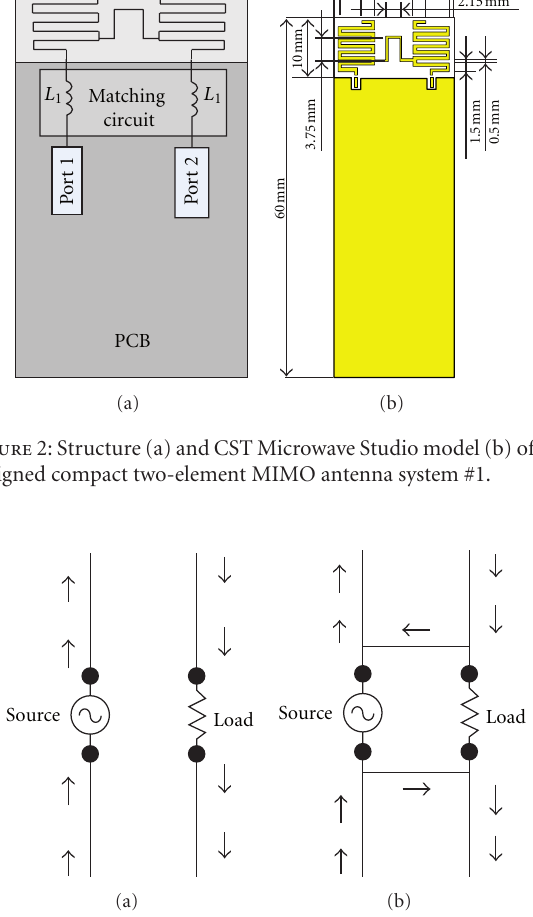
Figure 3: Antenna elements without (a) and with (b) direct connection lines.